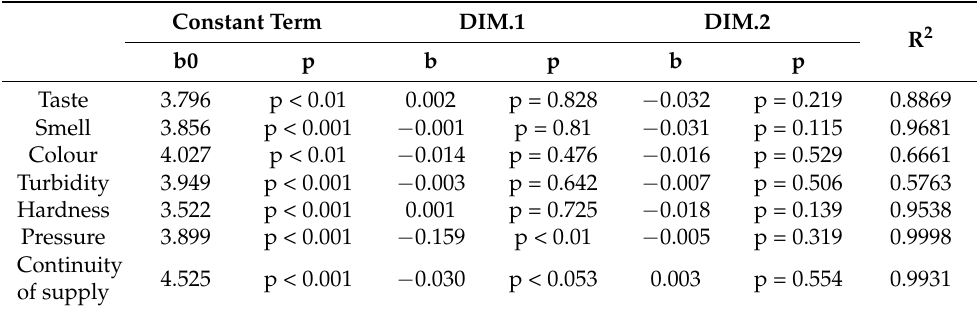
Table 5. Results of regression analysis between tap water parameters and the dimensions of examined units.